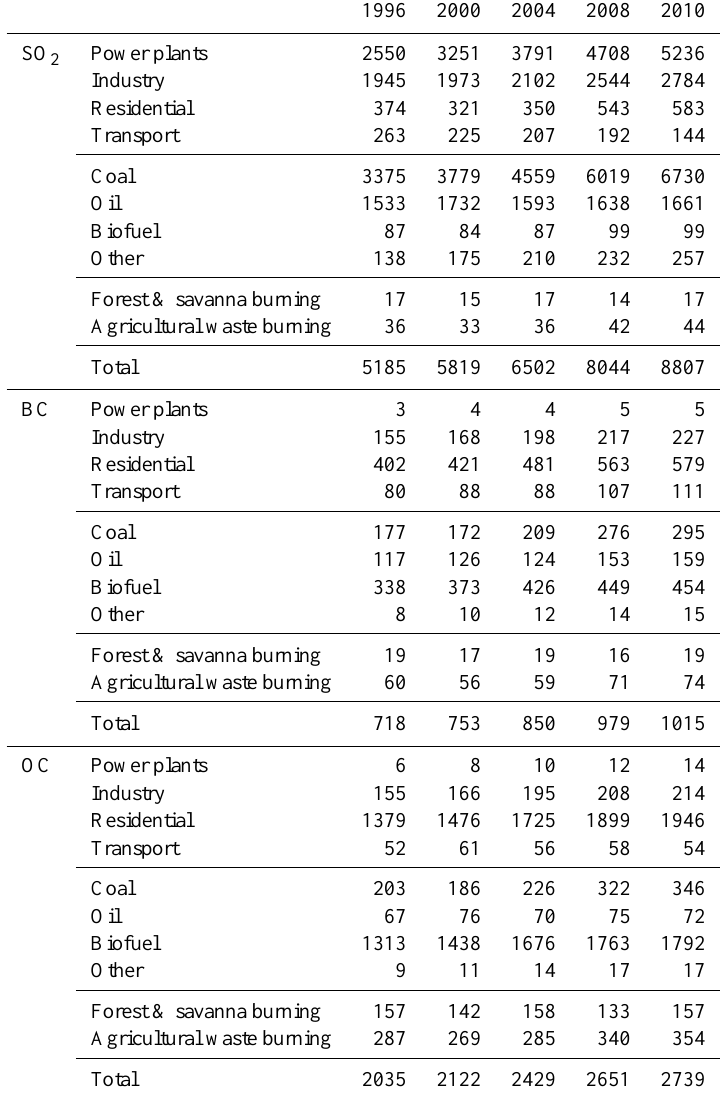
Table 2. Emissions of SO 2 , BC, and OC in India by sector and fuel type